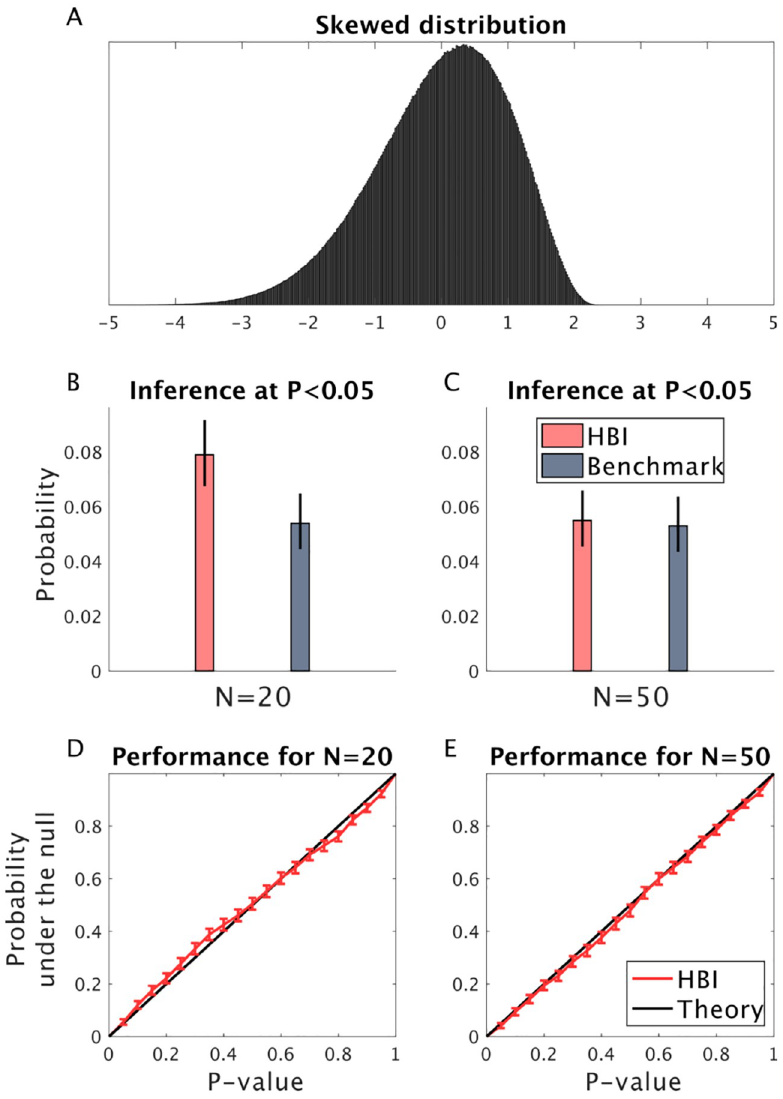
Fig 12. Performance of the HBI t-test when samples are drawn from a skewed distribution. A) The skewed distribution (skewness of − 0.5). The mean, variance and kurtosis of the distributions are 0, 1 and 3 (i.e. kurtosis of the normal distribution), respectively. This distribution was used to generate the bias parameter, which was then used to generate 20 (A) and 50 (B) subjects according to the biased RL model. B-C) Inference at P < 0.05 for the HBI t-test on estimated parameters and t-test on true parameters, as a benchmark, when there is no effect (under the null). Note that this is an unrealistic benchmark because it is based on true parameters that the HBI does not have access to. D-E) Probability of P-value is obtained under the null hypothesis by repeating simulations 2000 times. Under the null hypothesis, the resulting P-value is theoretically expected to have a uniform distribution. Increasing the number of subjects improves the performance of the HBI t-test. The error-bars are 95% confidence intervals for the binomial